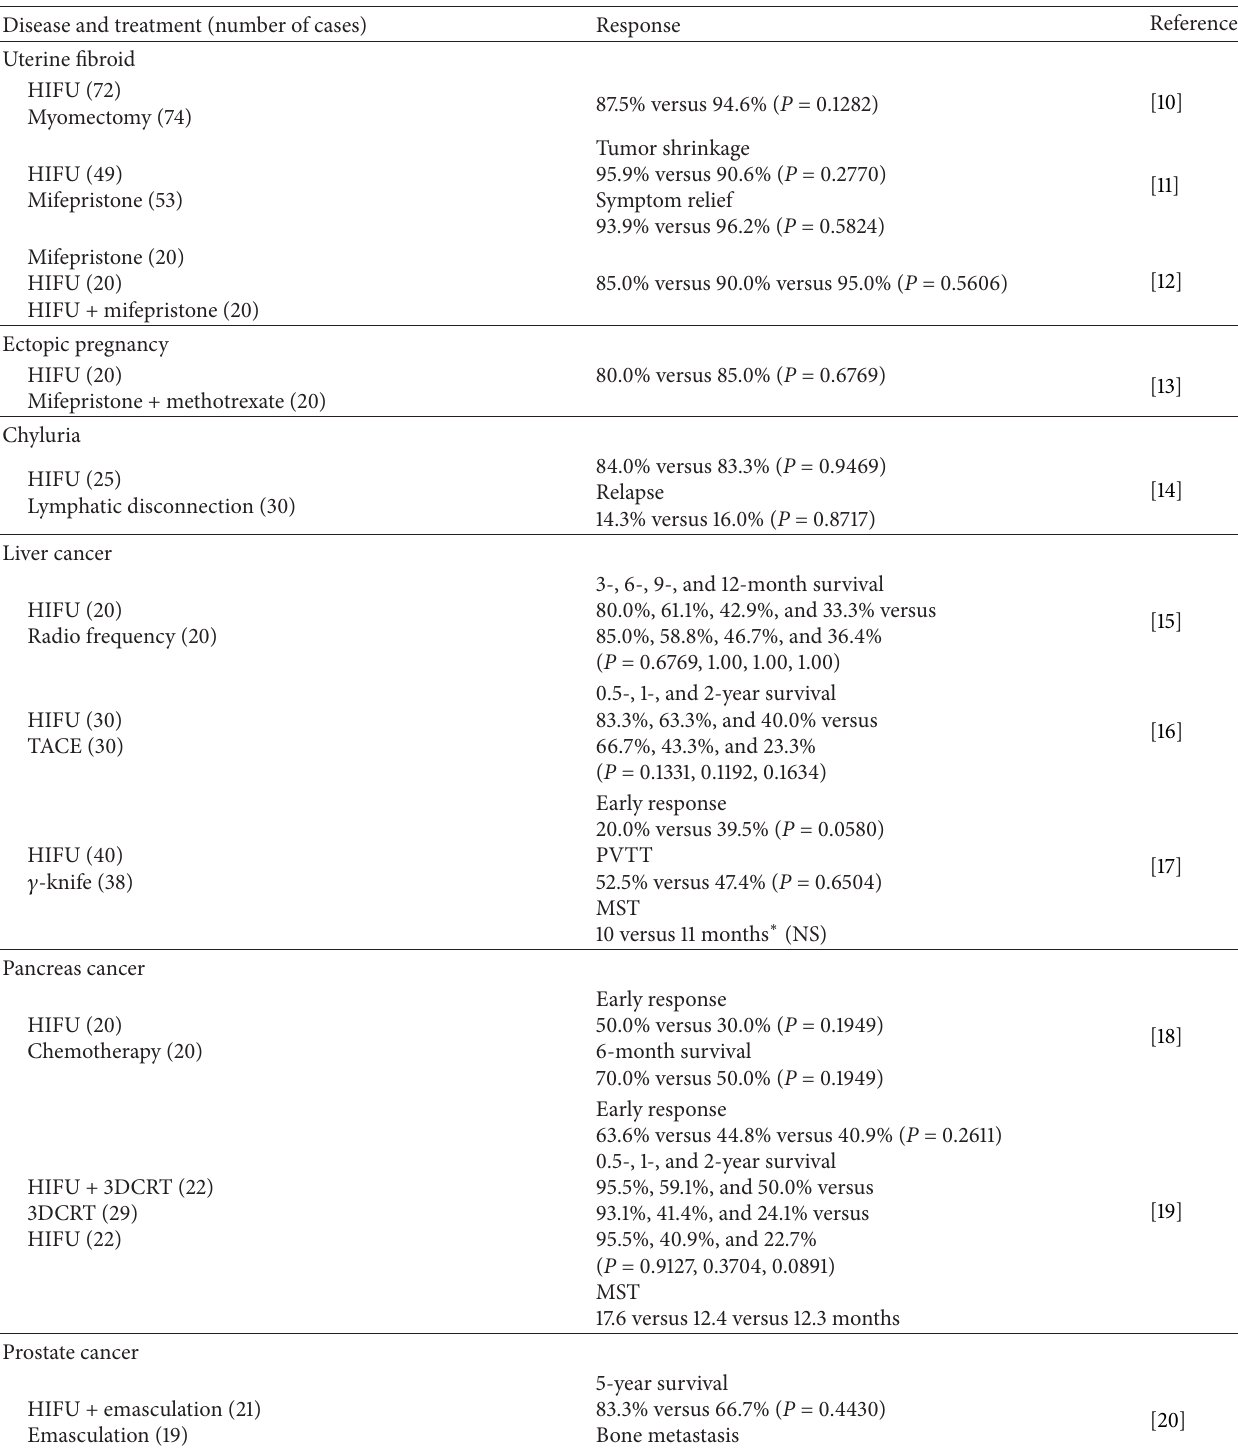
Table 2: The efficacy of HIFU in controlled